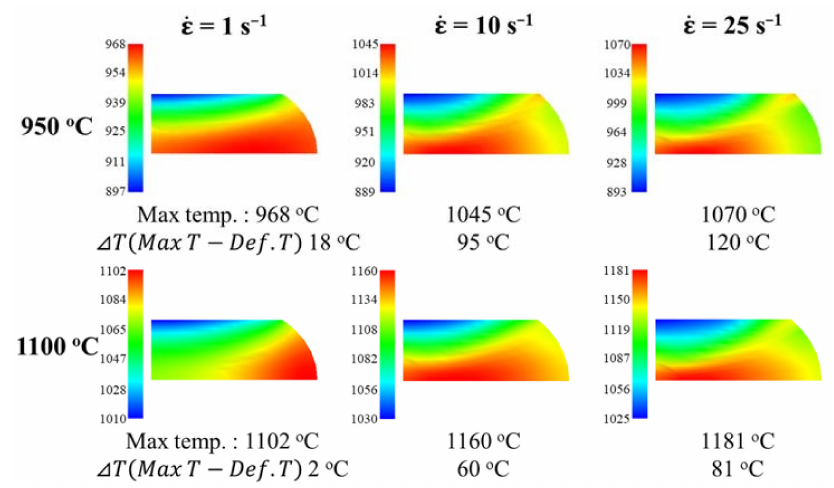
Figure 4. Temperature distribution (1/4 axisymmetric model) at deformation temperatures of 950 and 1100 ◦ C, a 60% height reduction, and strain rates of 1, 10, and 25 s − 1 .